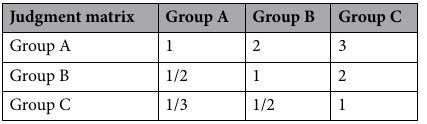
Table 4. Judgment matrix of AHP multi-level indicators.